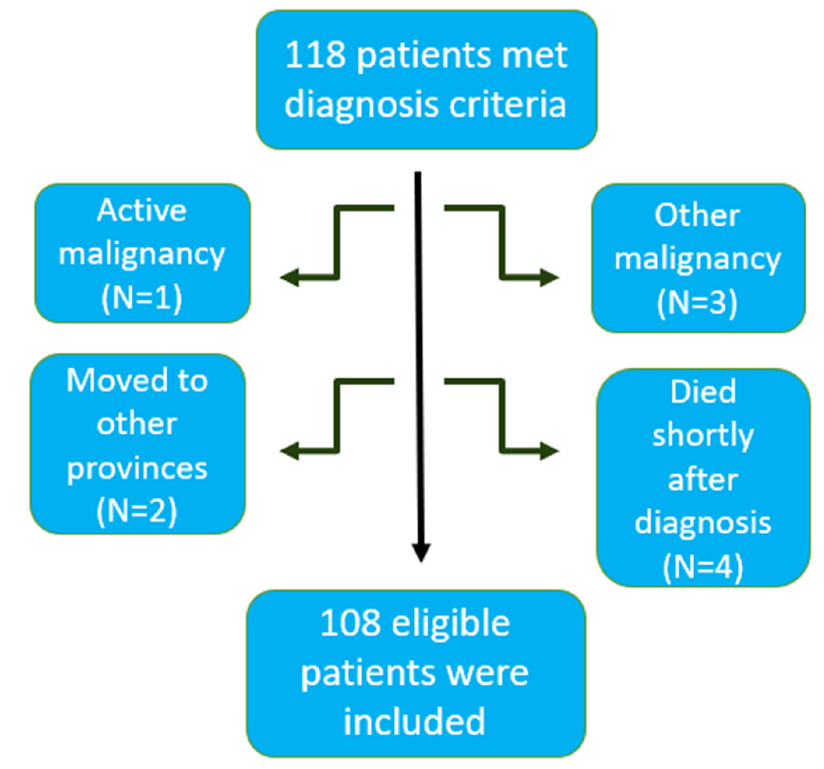
Figure 1. Flowchart of eligible participants evaluated. Table 1. Baseline Characteristics of